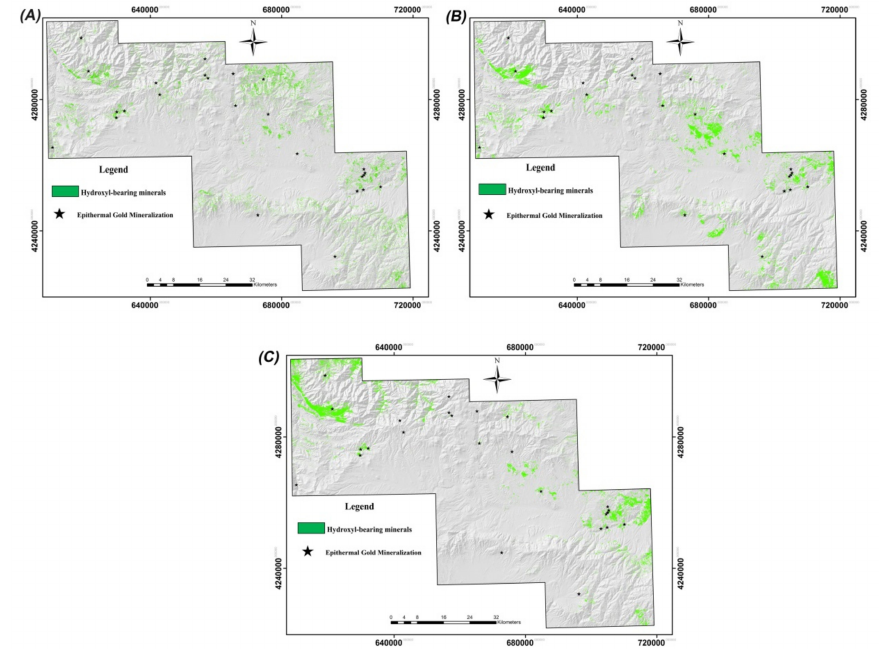
Figure 6. Spatial distribution of hydroxyl-bearing minerals and carbonates in the study area overlaid on hill shade. ( A ) The 5 / 7 band ratio image of Landsat-7 ETM + ; ( B ) the 6 / 7 band ratio image of Landsat-8; ( C ) the 4 / 9 band ratio image of